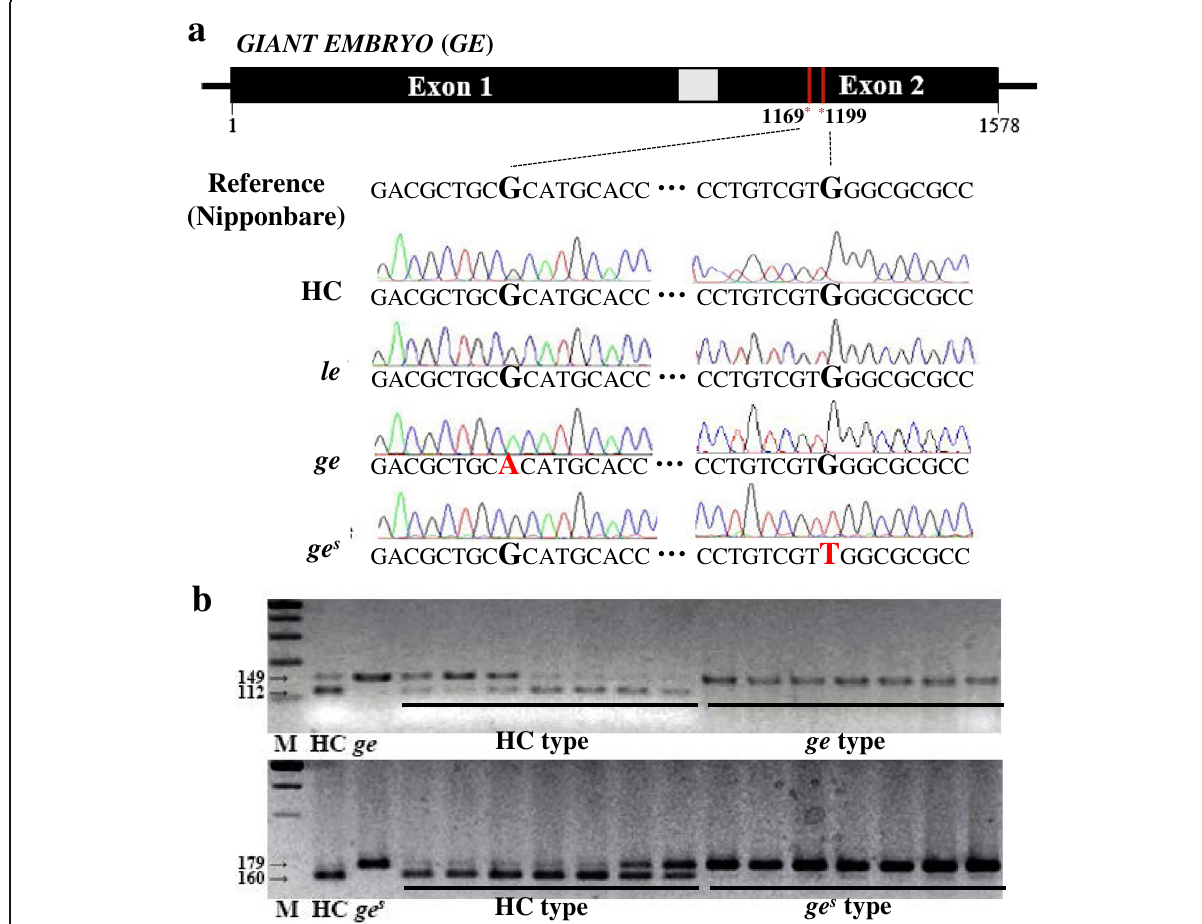
Fig. 3 Sequence analysis of the GE locus. a Identification of mutations in GE locus. b Co-segregation test of mutation point and enlarged embryo phenotype in F 2 seeds derived from HC/ ge and HC/ ge s